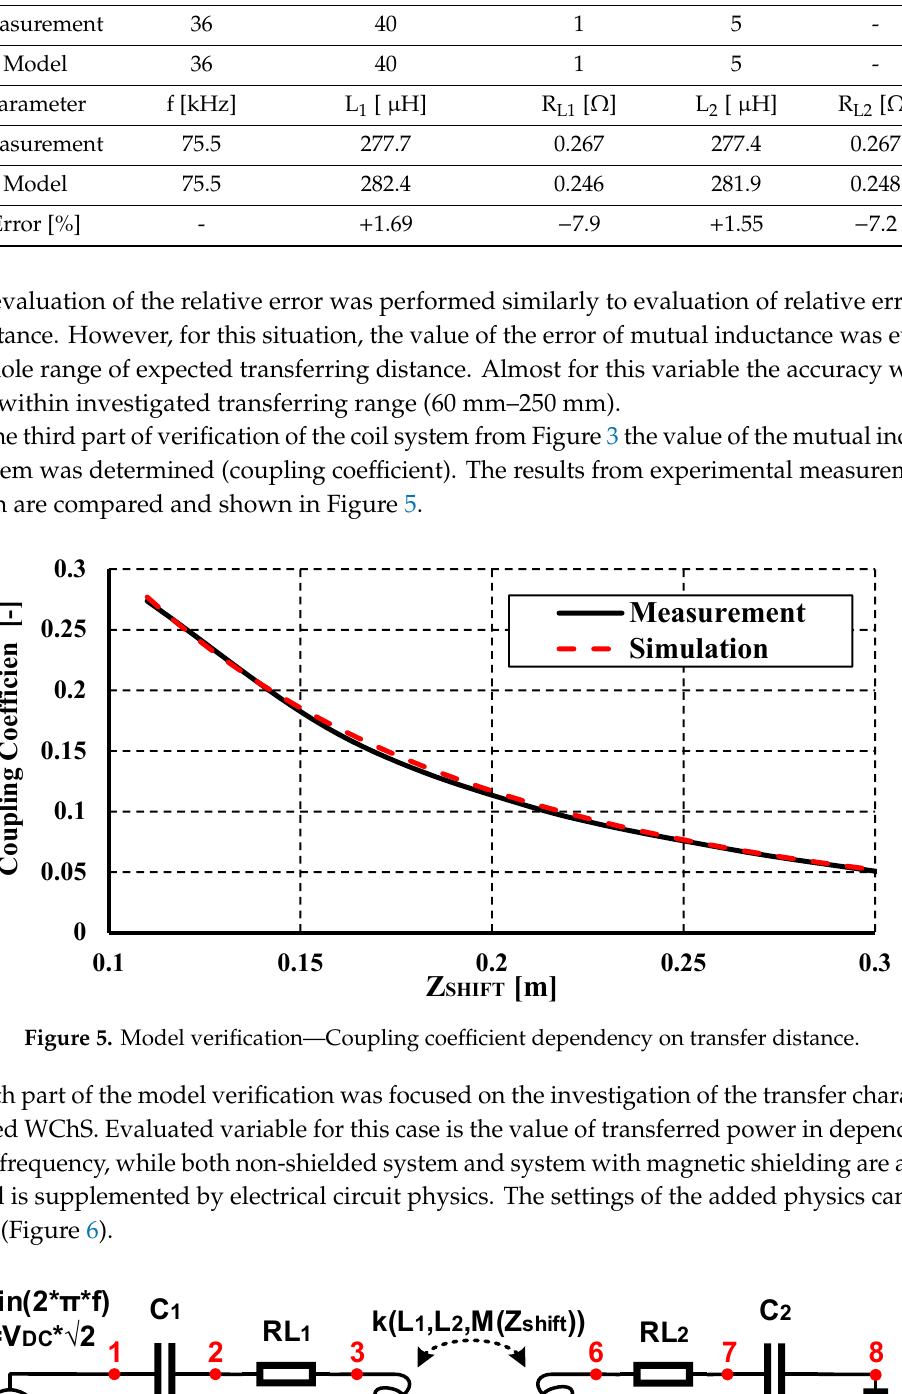
Table 4. Electrical circuit settings.